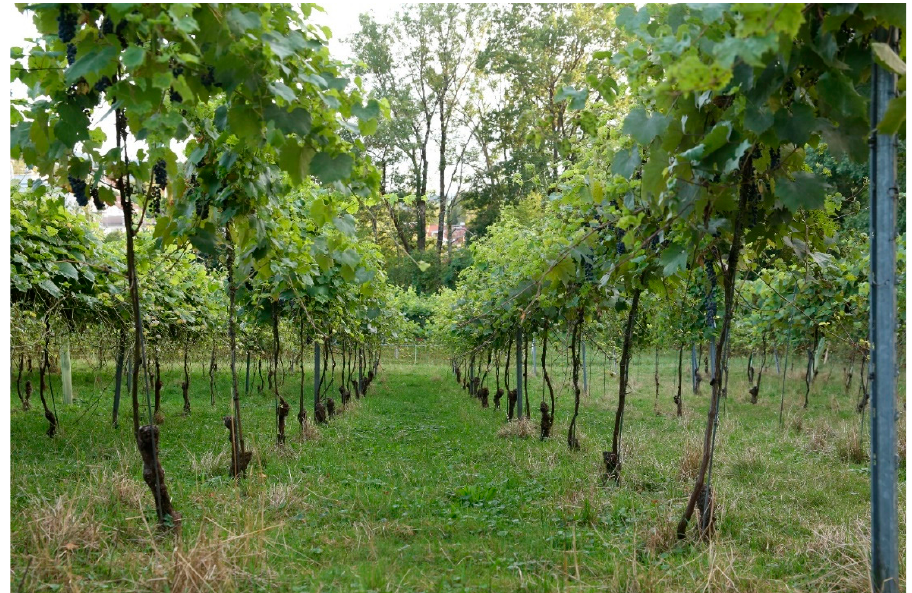
Figure 4. Top-wire cordon system. This vine training system is rather uncommon in Central Europe. It would be optimal for grazing because the grape zone is very high (>140 cm). In our study, we focused on a viticultural system that is more widespread. In this common system (see Figures 1 and 2), the browsing-sensitive phases of the growing season last from several weeks to a few months, depending on the grape variety. In such phases, grazing, even with breeds that are suitable in principle, is only possible if the flowers and grapes are protected from browsing (e.g., with an electric wire).